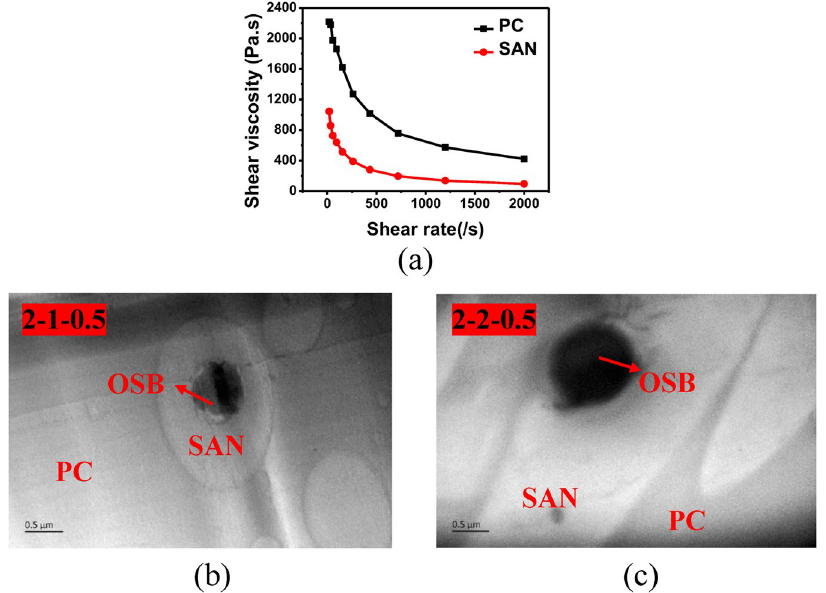
Figure 5. ( a ) Melt viscosity versus shear rate of PC and SAN at 240 °C. ( b , c ) TEM images of 2-1-0.5 and 2-2-0.5.